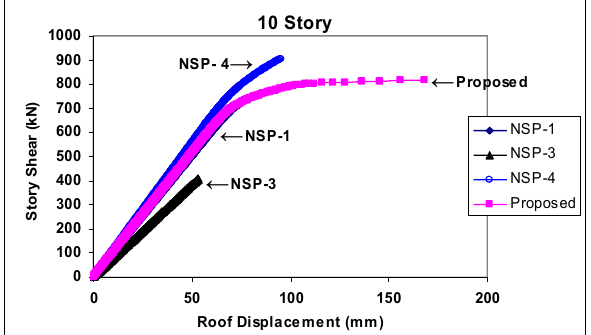
Figure 15. Base shear vs. roof drift response using different lateral load profiles for 6-storey building